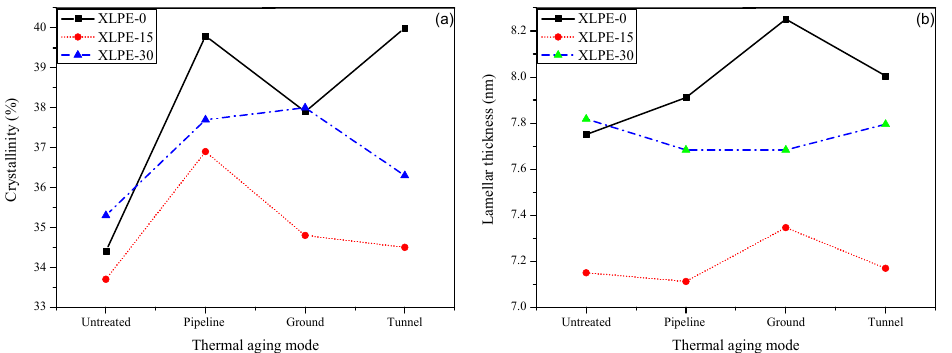
Figure 9. Changes on crystallinity and lamellar thickness of the main endothermic peak with different thermal aging modes: ( a ) Crystallinity; ( b ) lamellar of thickness.